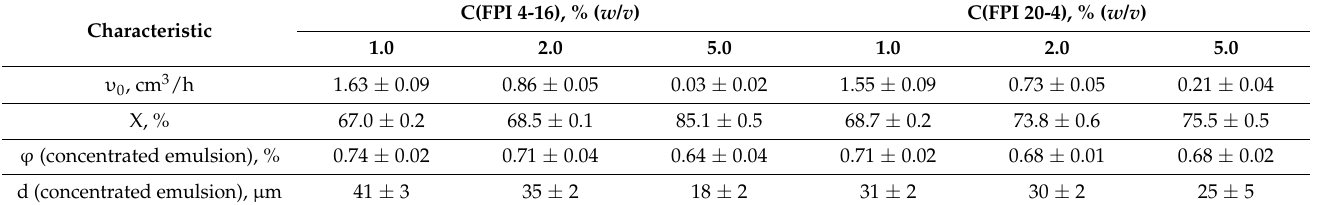
Table 4. Characteristics of oil/water emulsions stabilised with different concentrations of FPIs.